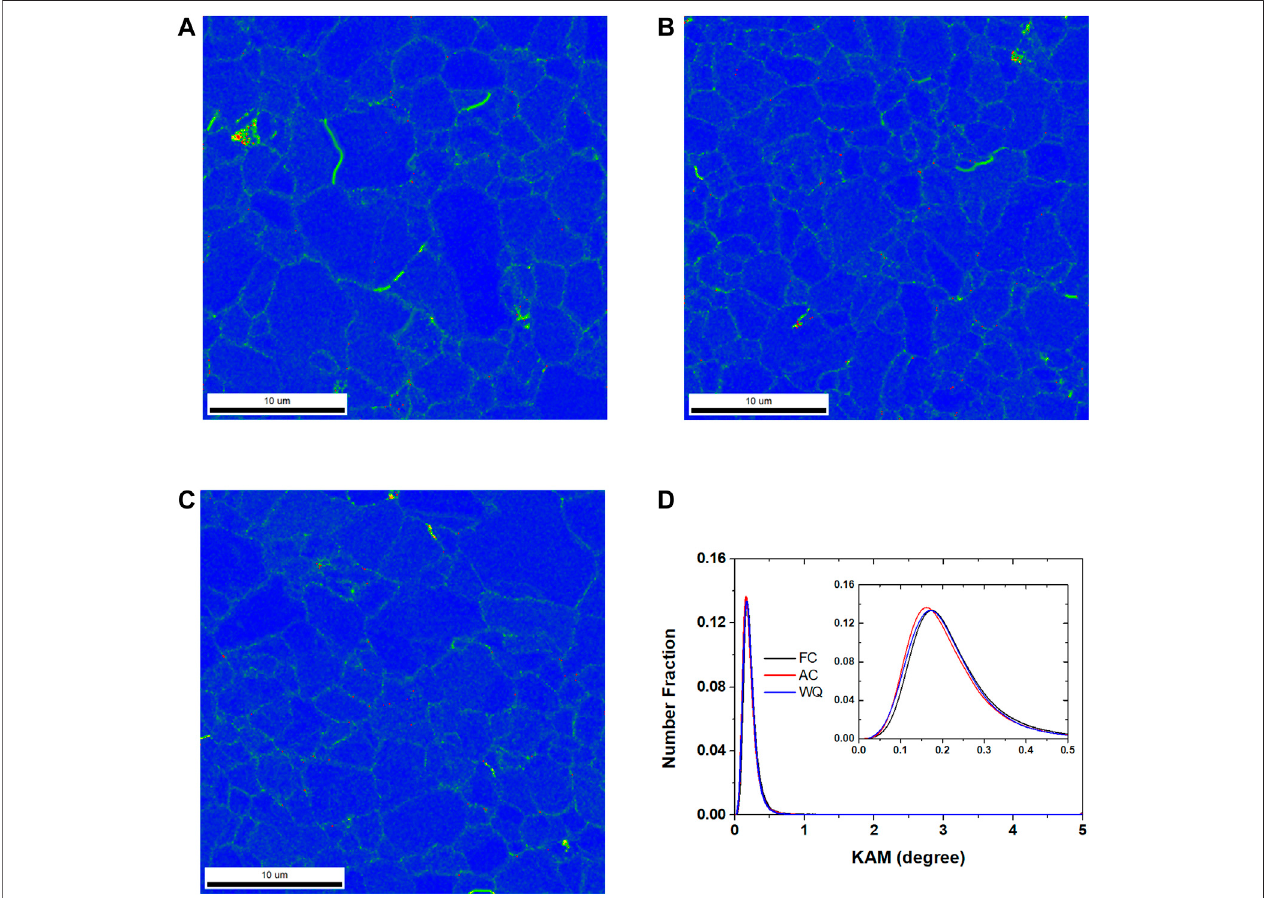
FIGURE 2 | The EBSD Kernel average misorientation (KAM) maps of a Fe-18Mn-0.6C-1.5Al twinning-induced plasticity (TWIP) steel specimen annealed at 700 ° C for 5 min followed by (A) furnace cooling (FC), (B) air cooling (AC), and (C) water quenching (WQ). (D) Corresponding KAM pro fi les. Inset is an enlarged section of the KAM pro fi